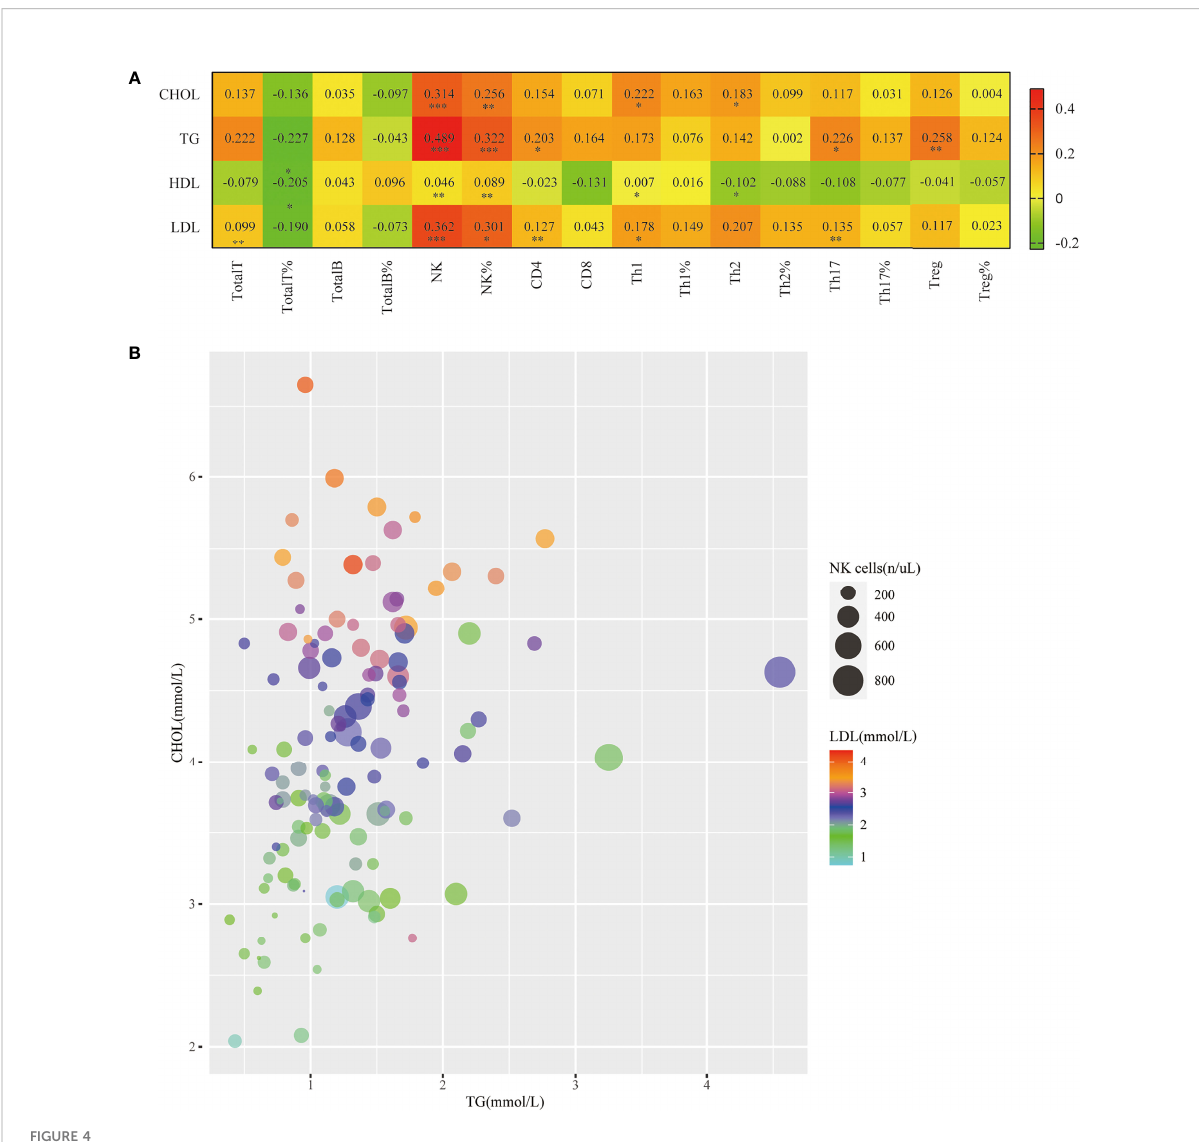
FIGURE 4 Correlation of peripheral blood NK cell levels with hyperlipidemia in patients with PsA. (A) . Heatmap of correlation of the serum lipid levels (TG, CHOL, LDL, HDL) with Total T, Total T%, Total B, Total B%, NK, NK%, CD4+T, CD8+T, Th1, Th1%, Th2, Th2%, Th17, Th17%, Treg, Treg%. (* p < 0.05, ** p < 0.01, *** p < 0.001; by Spearman correlation test ). (B) . Correlation bubble plot of TG, CHOL, LDL, and peripheral blood NK cell